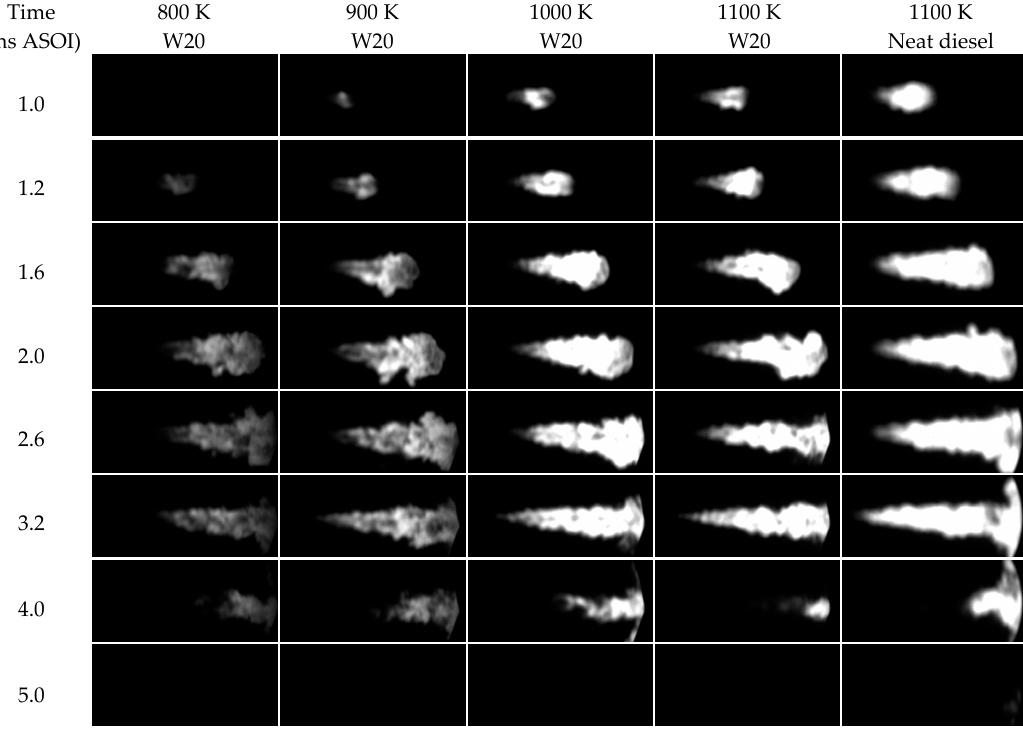
Figure 9. Flame evolution of neat diesel under 1100 K and W20 under various ambient temperatures.